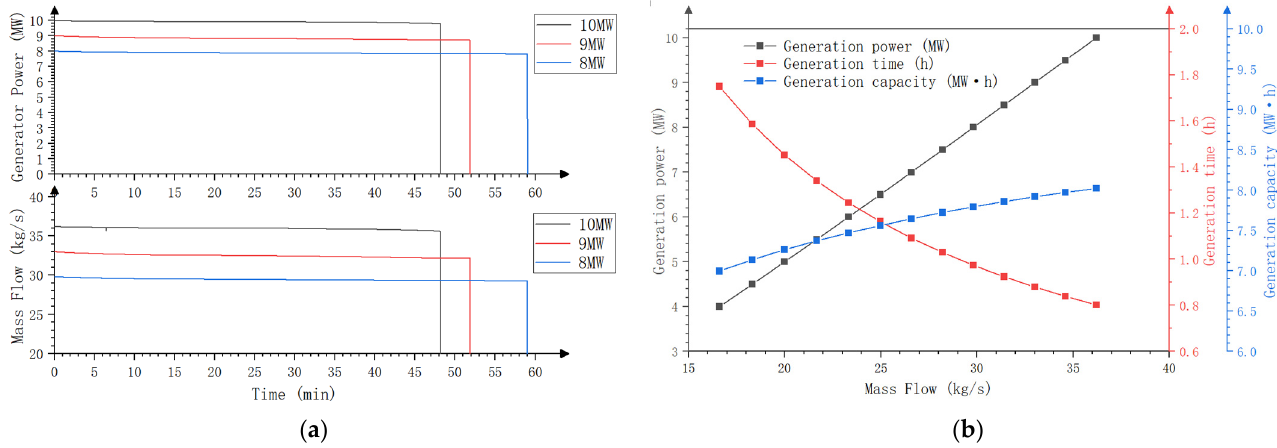
Figure 3. ( a ) Operating parameters under short-timescale conditions. ( b ) Relation diagram of different mass flow of compressed air with power-generation capacity and power-generation time.